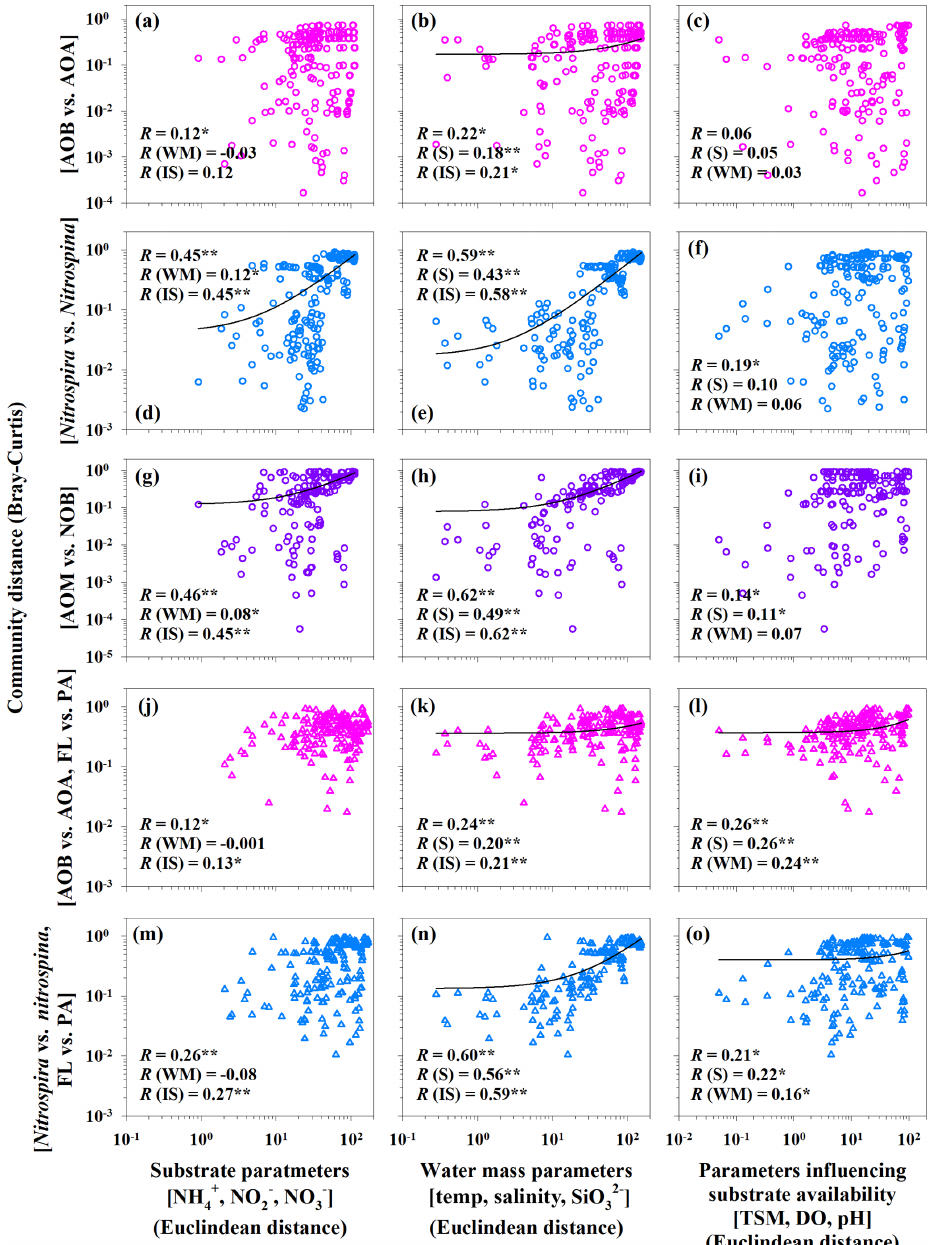
Figure 11. Correlations between nitrifier community composition and water mass parameters (temperature, salinity, and silicate), substrate parameters (ammonia/ammonium, nitrite, and nitrate), or parameters influencing substrate availability (TSM, DO, and pH). Standard and partial Mantel tests were run to measure the correlation between two matrices. Dissimilarity matrices of nitrifier communities were based on Bray–Curtis distances; environmental factors were based on Euclidean distances between samples. Spearman or Kendall’s correlation coefficient ( R ) values are shown for standard (first value) and partial Mantel (second and third) tests. The P values were calculated using the distribution of the Mantel test statistics estimated from 999 permutations. ∗ P< 0 . 05; ∗∗ P< 0 . 01. Matrix of the nitrifier community was calculated according to (a–c) ammonia-oxidizing archaeal and bacterial abundances (AOB vs. AOA), (d–f) Nitrospira and Nitrospina abun- dances ( Nitrospira vs. Nitrospina ), (g–i) ammonia- and nitrite-oxidizing microbial abundance (AOM vs. NOB), (j–l) FL and PA ammonia- oxidizing archaeal and bacterial abundances (AOB vs. AOA, FL vs. PA), and (m–o) FL and PA Nitrospira and Nitrospina abundances ( Nitrospira vs. Nitrospina , FL vs. PA). (a, d, g, j, m) Matrix of substrate parameters included NH + h, k, n) matrix of water mass parameters included temperature (temp), salinity, and SiO 2 − substrate availability included TSM, DO, and